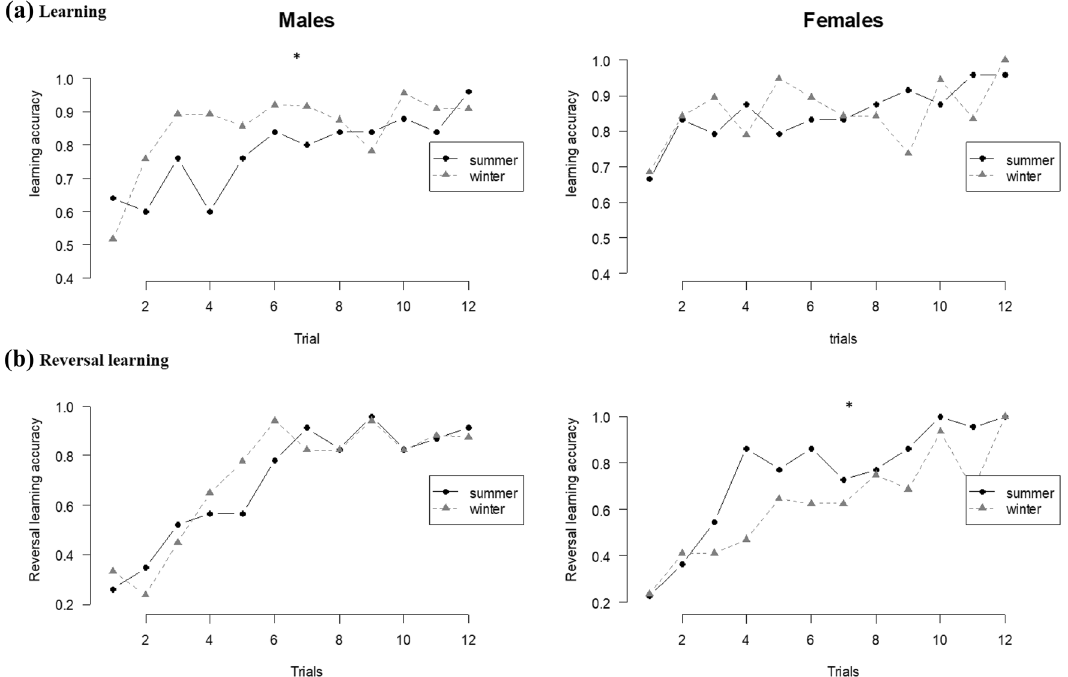
Figure 2. Learning curves in ( a ) the learning (N females = 41; N males = 46) and ( b ) the reversal learning tasks (N females = 38; N males = 40), for the 12 first successive trials. The left panels show males and right panel females. Mice tested in summer are represented with black dots and full black lines and mice tested in winter are represented with grey triangles and gray dashed lines. Post hoc t test with Tukey correction, *P ≤